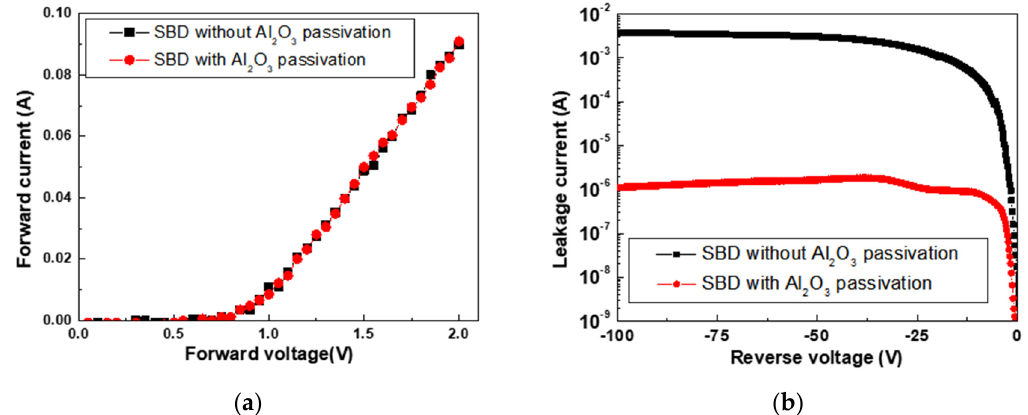
Figure 7. ( a ) Forward and ( b ) reverse I–V curves of the AlGaN/GaN SBDs with and without ALD Al 2 O 3 passivation layer deposited at 550 °C.